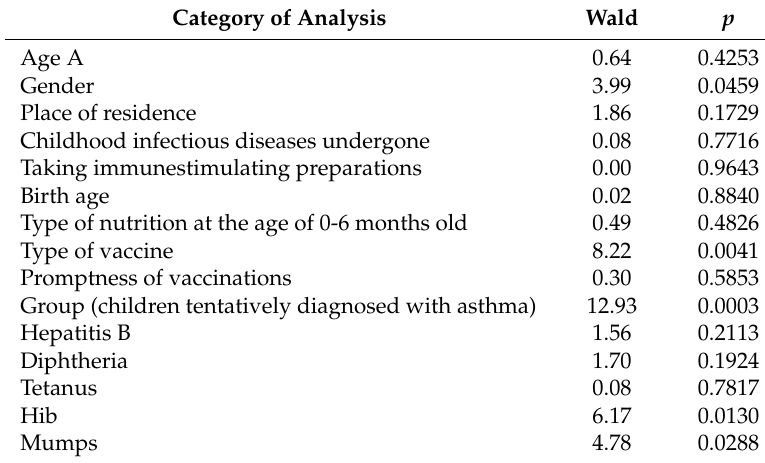
Table 4. Generalised Linear Model (GLZ) Multiple Regression (Probit Model, Best